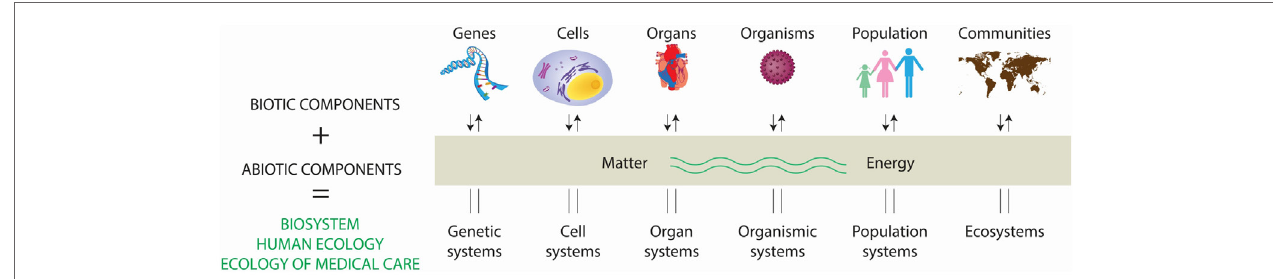
FiGURe 1 | interaction of living and non-living components in the conformation of the biosystem . A system consist of regularly and interdependent components forming a unified whole. Systems containing living (i.e., biotic) and non-living (i.e., abiotic) components constitute biosystems, and range from genetic systems to ecosystems, all of them influencing their function and homeostasis. This multifactorial biosystem has a major effect in health, resulting into the concept of “the ecology of medical care.” Adapted from Ref. (4).